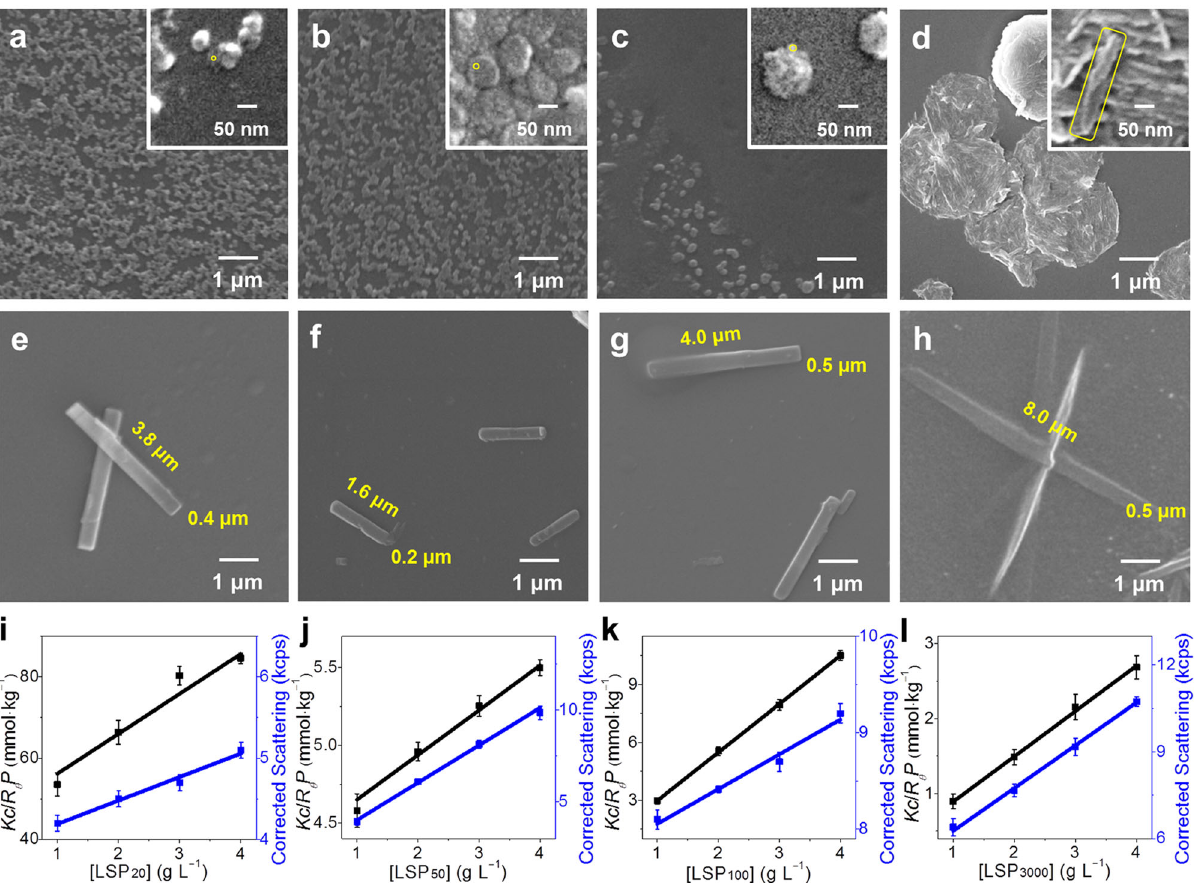
Fig. 2 Tuning the size of LSP via LDH con fi nement. a − d SEM images of metastable LSM prepared from SG7-LDHs with different size: a 20 nm, b 50 nm, c 100 nm, and d 3 μ m (insets are corresponding magni fi cations and the sizes of metastable LSM in the insets are marked with a yellow line). e – h SEM images of elongated LSP from the corresponding metastable LSM in a – d , respectively. i – l Debye plot of metastable LSP made of corresponding metastable LSM in a – d , respectively. Error bars are calculated using the standard error formalism for the data of three replicate